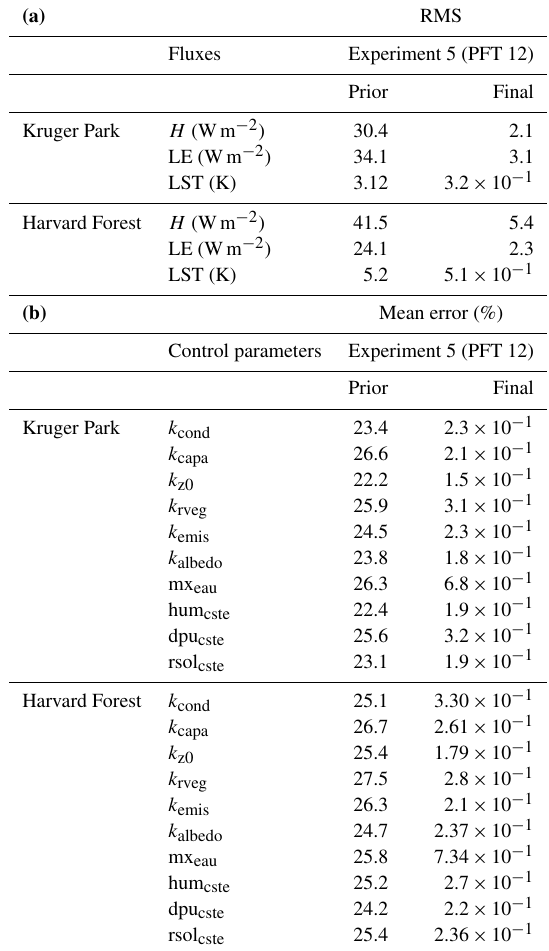
Table 9. Results for Experiment 5 (PFT 12). RMSE of model fluxes (a) and parameter relative errors (b) before and after the assimi- lation process, on the FLUXNET Harvard Forest and Kruger Park